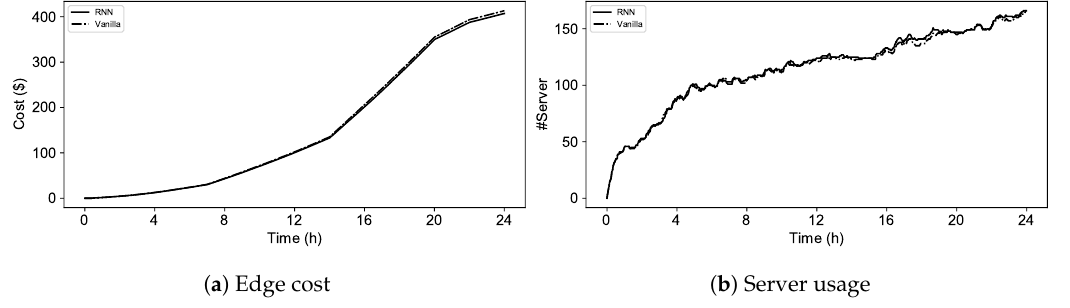
Figure 7. RNN versus vanilla server